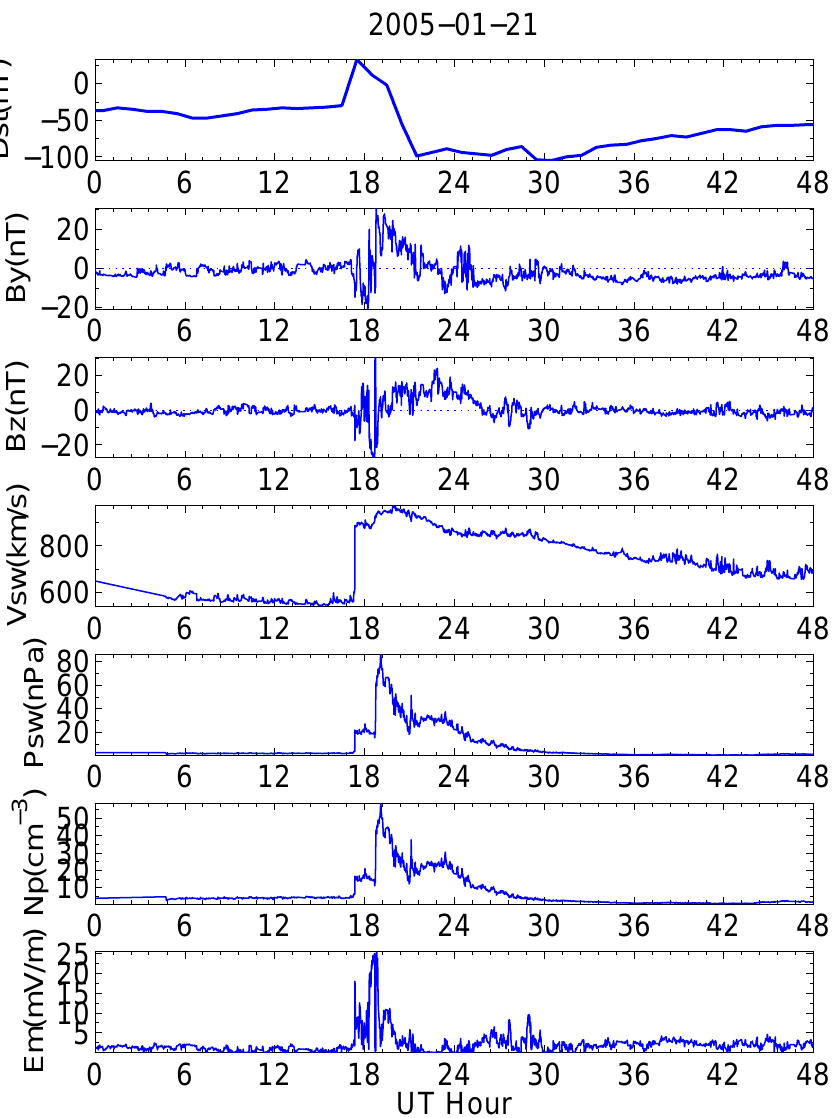
Fig. 9. The solar wind conditions for the storm during 21 to 22 January 2005. From top to bottom are Dst index, IMF B y , IMF B z , solar wind speed v SW , solar wind dynamic pressure P SW , solar wind proton number density N p and merging electric field E m